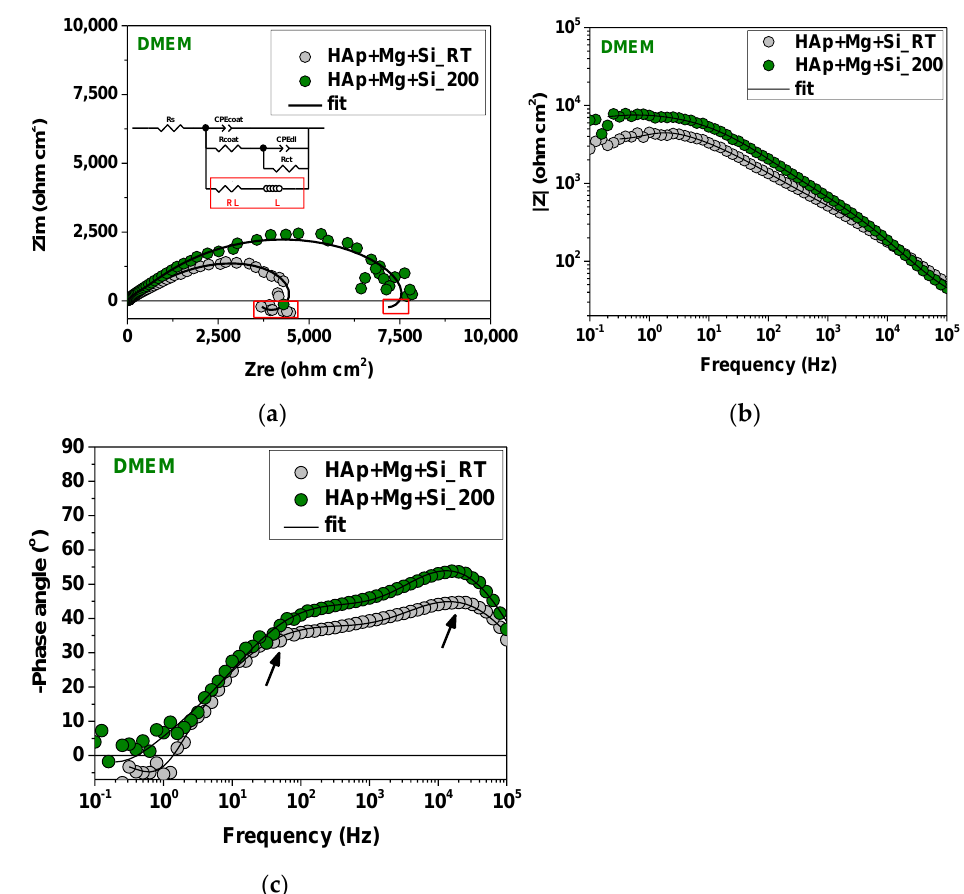
Figure 7. EIS curves of the investigated specimens immersed in DMEM: ( a ) Nyquist plots, ( b ) |Z| plots, ( c ) Phase angle plots. (R s = the solution resistance, CPE coat = coating capacitance, R coat = resistance associated with the current flow, CPE dl = double layer capacitance, R ct = charge transfer resistance, L and RL were used to simulate the inductive behaviour).